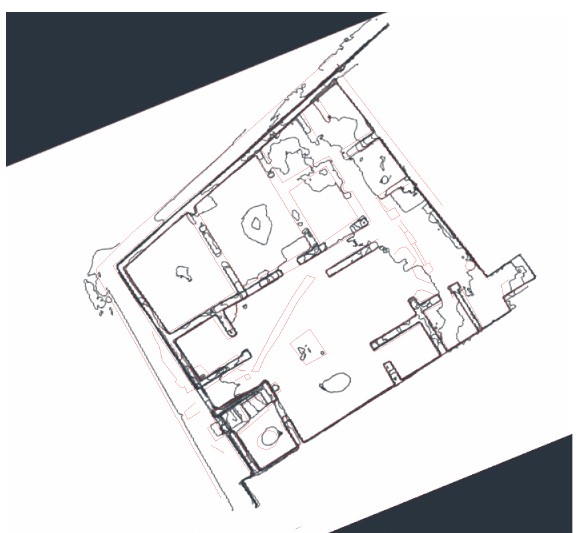
Figure 7. Overlap of the plants produced with total station (red) and with the 3D model (black)